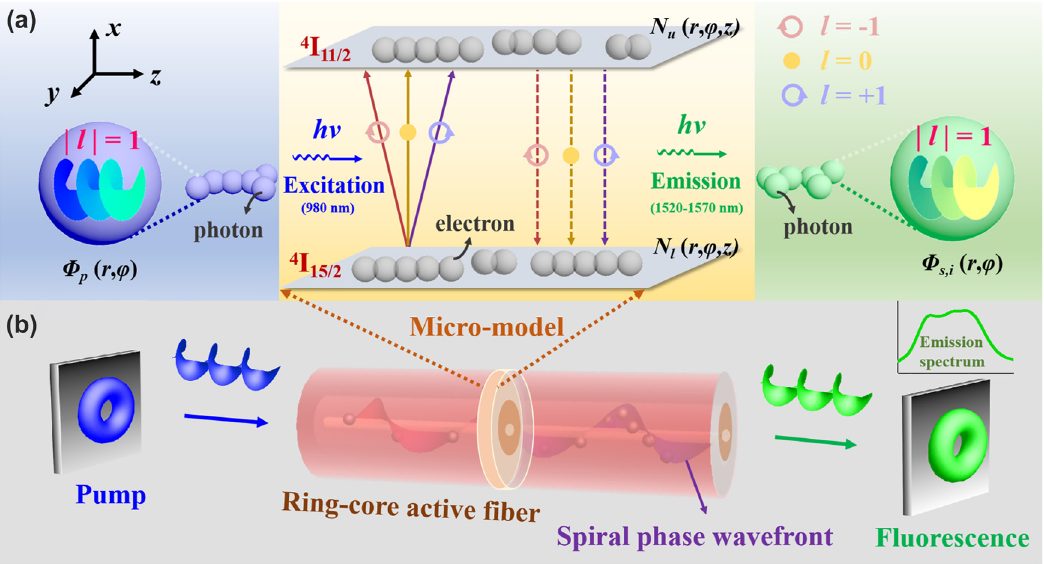
and 4 I . When the 15/2 11/2 in the form of spontaneous emission, during which the same 15/2